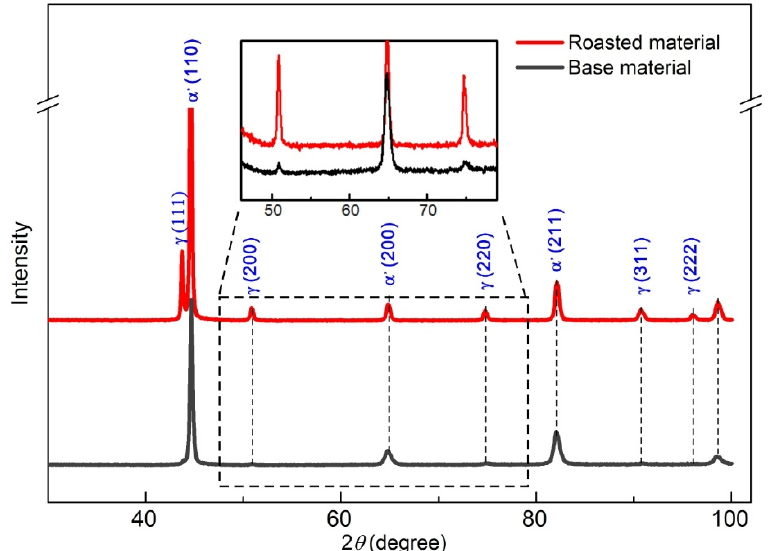
Figure 6. X-ray diffraction patterns of the base material and material from the roasted block. The position of the XRD sample for material from the roasted block is indicated by C in Figure 5a.